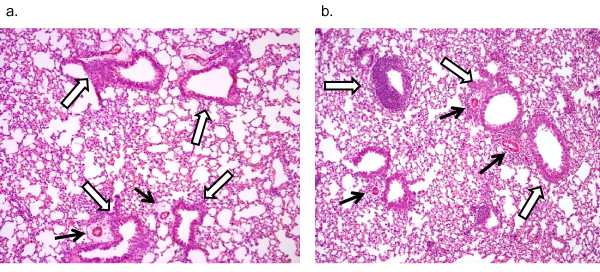
Histological changes in offspring from mothers exposed to saline or A. fumigatus. a.) Representative histology from lungs of offspring whose mother was treated with saline following 5 doses of A. fumigatus starting at 9-10 weeks. The photomicrograph was taken from a lung section stained with Hematoxylin and Eosin. White arrows point to perivascular and peribronchial inflammation, black arrowheads point to mild arterial muscularization. b.) Representative histology from lung of offspring whose mother was treated with A. fumigatus following 5 doses of A. fumigatus starting at 9-10 weeks. The photomicrograph was taken from a lung section stained with Hematoxylin and Eosin. White arrows point to perivascular and peribronchial inflammation, black arrowheads point to arterial muscularization. No differences were observed among offspring of mice that received diesel exhaust, particles when compared to offspring of mice that received saline. No differences were observed among offspring of mice that received diesel and A. fumigatus, compared to A. fumigatus alone.